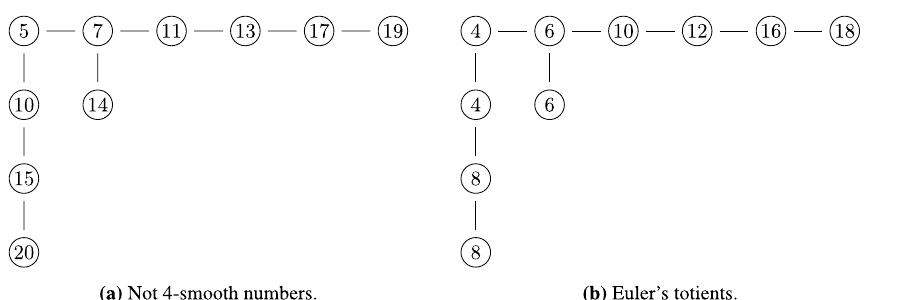
20 . The tree of = ( 2, 3 ) . Thus, each left =